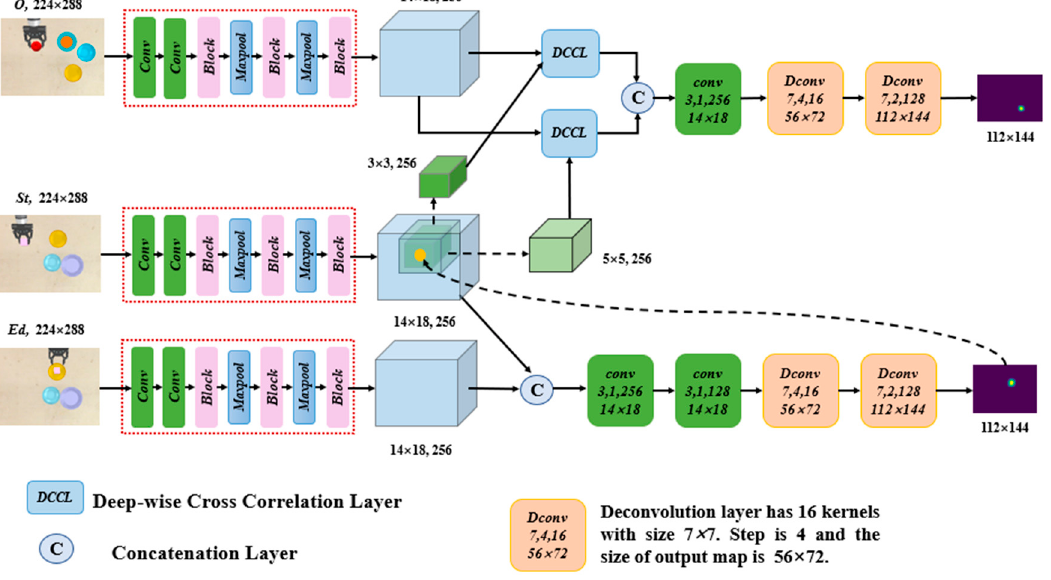
Figure 3. The structure of the object detection network